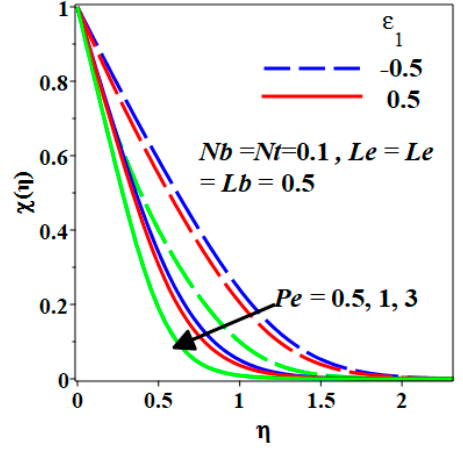
Figure 5. Variation of Pe and ε 1 on χ ( η ) .